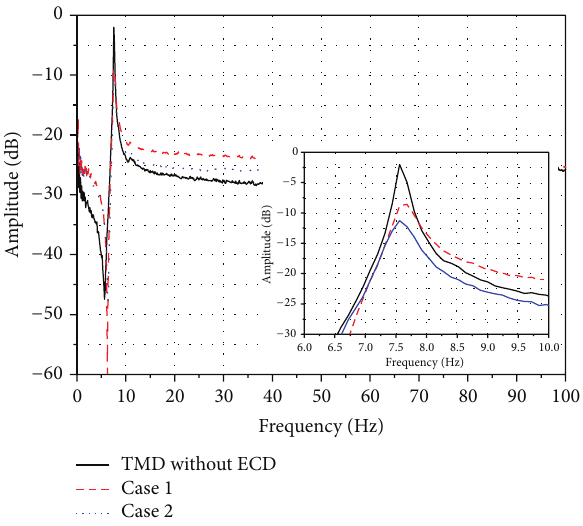
Figure 16: Frequency response functions of mTMD.